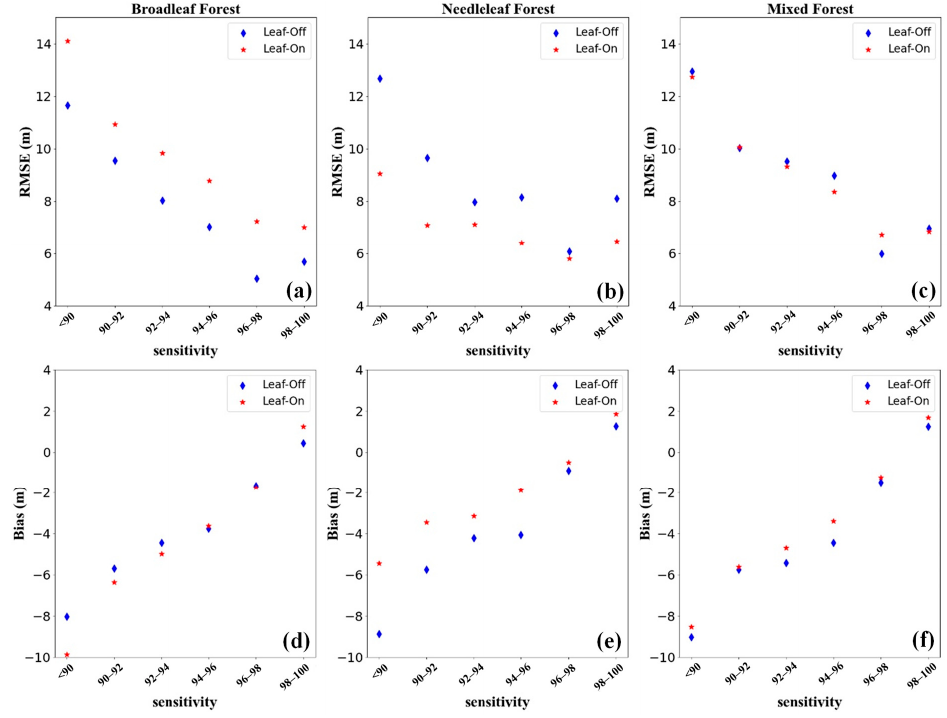
Figure 9. Relationship between accuracy criteria (RMSE and Bias) and sensitivity: ( a ) RMSE, broadleaf, ( b ) RMSE, needleleaf, and ( c ) RMSE, mixed forest, ( d ) Bias, broadleaf, ( e ) Bias, needleleaf, and ( f ) Bias, mixed forest in leaf-off and leaf-on seasons.